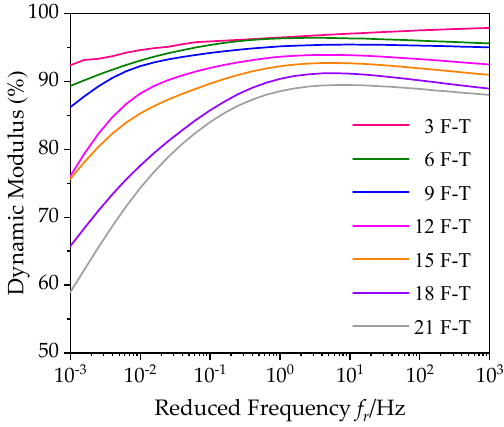
Figure 9. Trend of dynamic modulus ratios under F–T (reference temperature = 20 °C).